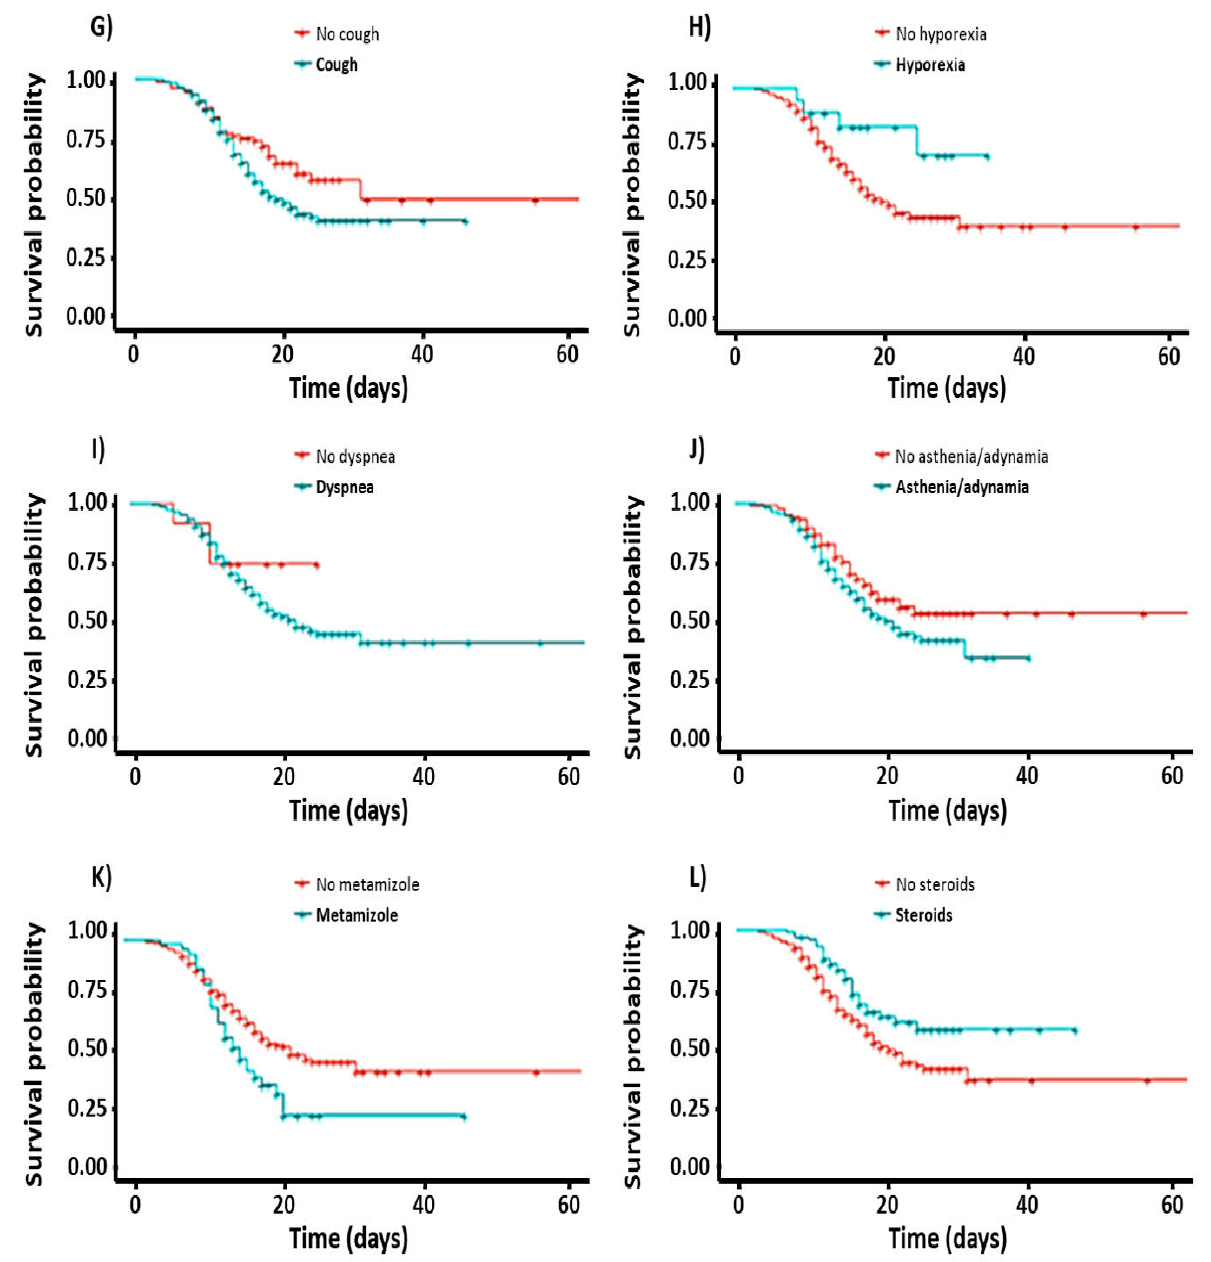
Figure 1. The overall survival curves and medians of subjects with moderate and severe pneumonia due to COVID-19 are presented in this image ( A ). Also shown are the survival curves associated with sex ( B ), the presence of comorbidities ( C ) and HBP ( D ), drug addiction ( E ), diabetes mellitus (DM) ( F ), cough ( G ), hyporexia ( H ), dyspnea ( I ), asthenia and adynamia ( J ), metamizole sodium use ( K ), and steroid use ( L ). Data were analyzed with a Kaplan–Meier curve, and statistically significant associations are assumed with a p < 0.05; in addition, 95% confidence intervals are presented for the median of each group (95% CI).